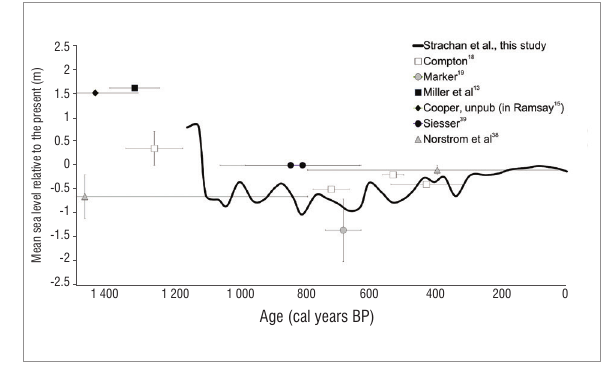
Figure 4: Reconstruction of relative sea-level change for Kariega Estuary.